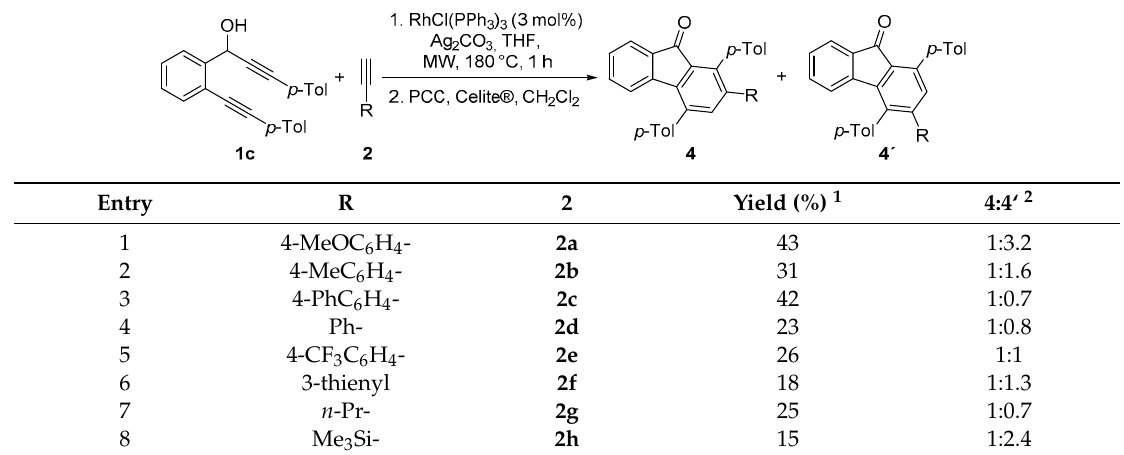
Table 1. Cyclotrimerization of 1c with 2 catalyzed by Wilkinson’s catalyst.